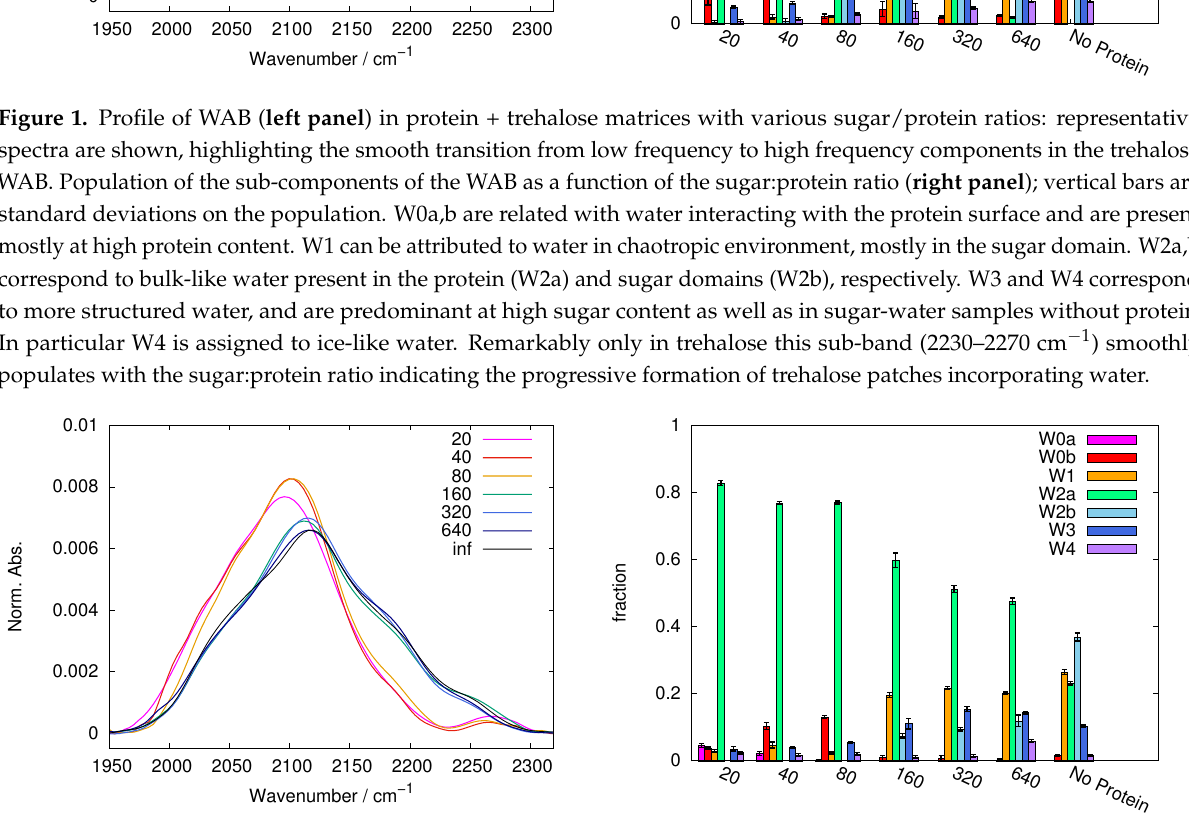
Figure 2. As for Figure 1, in protein + sucrose matrices. At variance with the trehalose case, the transition from high protein (low frequency) to high sugar (high frequency) content is sharp. W2a bulk-like is dominant at almost all sugar/protein